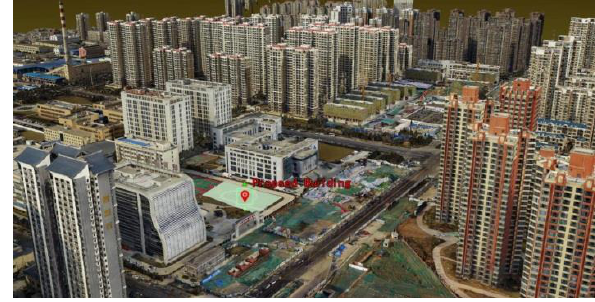
Figure 4.Location of proposed